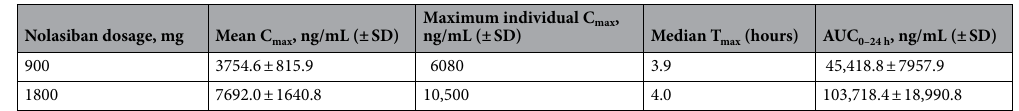
Table 2. Pharmacokinetic parameters following dosing with nolasiban.